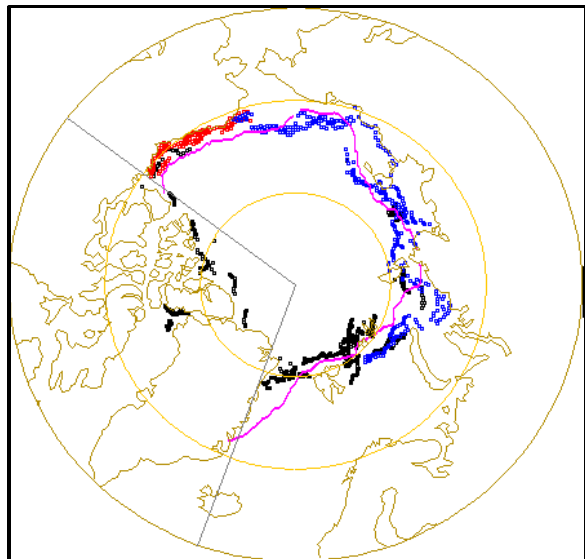
Fig. 6. Outline of September 1964 Arctic sea ice edge from Nim- bus I (black dots), Alaskan ice charts (red), and Russian ice charts (blue). The pink line is the 1979–2000 median ice edge from the passive microwave-based NSIDC Sea Ice Index product. The straight gray lines indicate the region filled in by the 1979–2000 average extent from the Sea Ice Index.